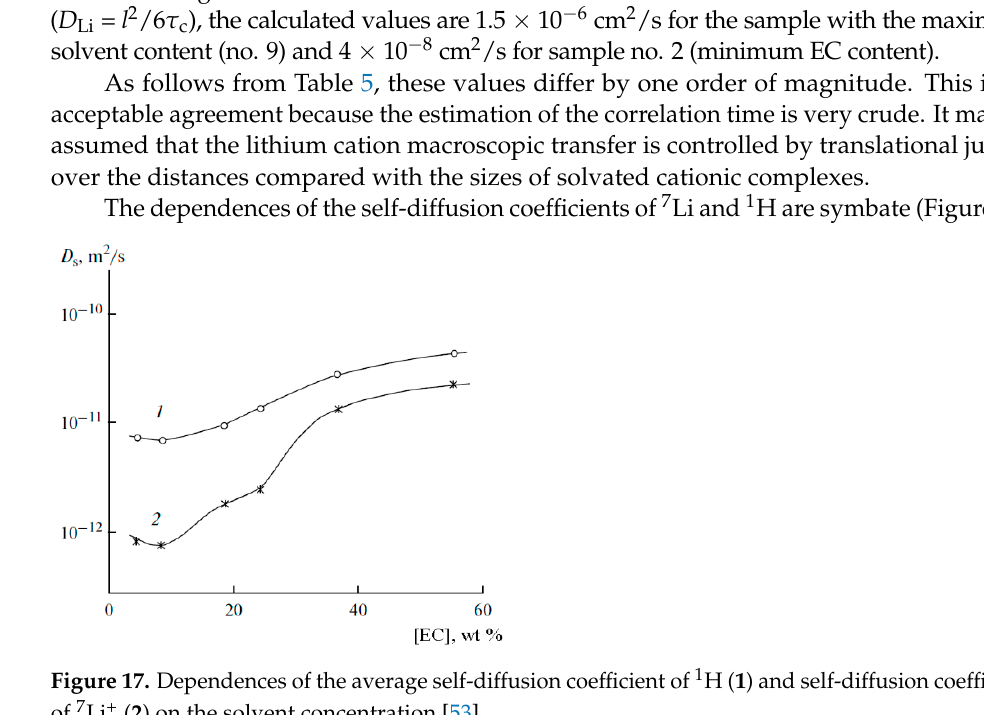
Figure 18. 1 H NMR spectra of SPE no. 9 at different temperatures [53].